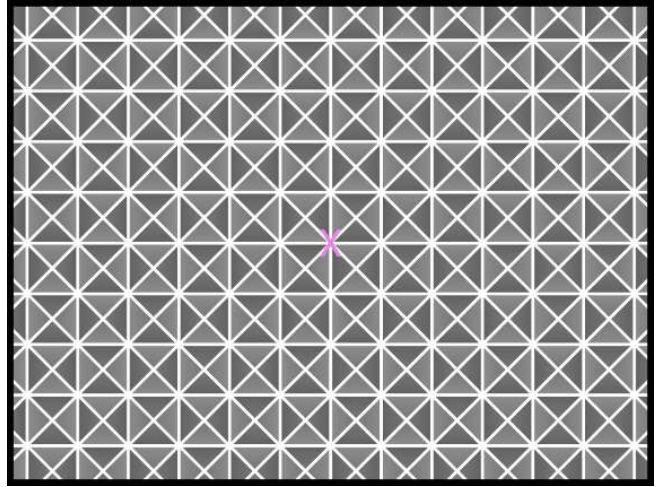
Figure 4. Pre-exercise symptom rating page.